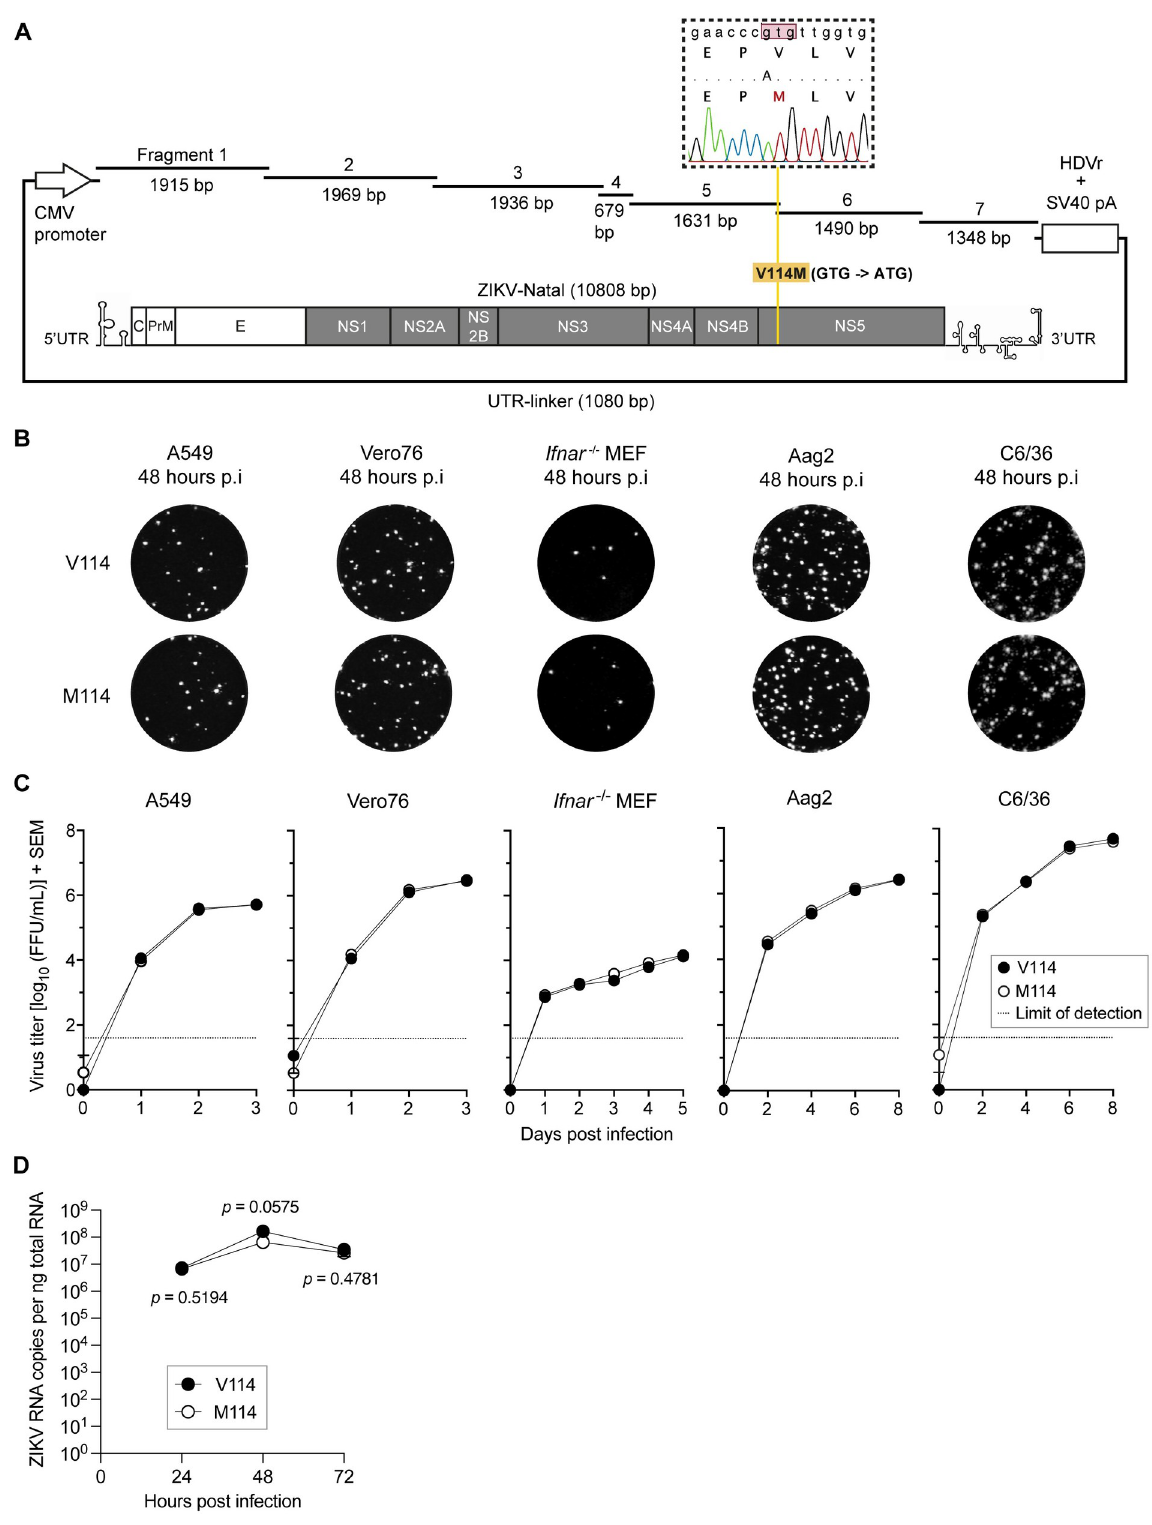
Fig 2. Generation of ZIKV NS5-V114M mutant (M114) based on ZIKV-Natal strain by CPER and its characterization in vitro [29]. ( A ) Schematic representation of the NS5-V114M mutation in the ZIKV-Natal genome and verification of the NS5-V114M mutation in CPER- recovered virus by Sanger sequencing. ( B ) Representative foci morphologies of indicated cells infected with either V114 or M114 ZIKV strains